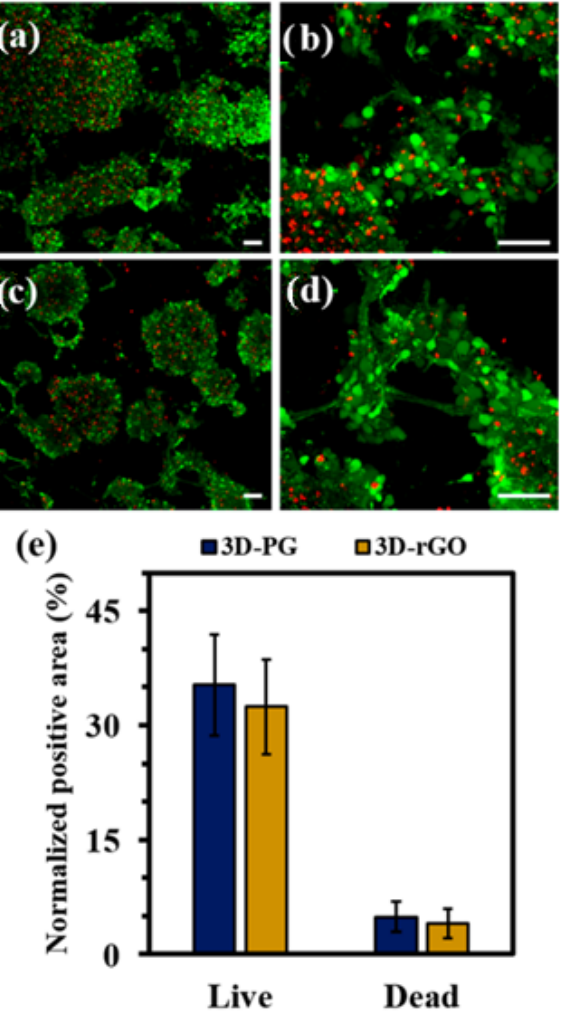
Figure 9. Confocal microscopy images of fibrous scaffolds with ENCP cells after cell culture: ( a , b ) fabricated from polycaprolactone-gelatin, then placed in rGO solution, ( c , d ) in which rGO was also already added to the polymer PG matrix, ( e ) chart of the area covered by live and dead ENCP cells on the fibrous materials. Reprinted with permission from [99]. Copyright 2022 American Chemical Society .